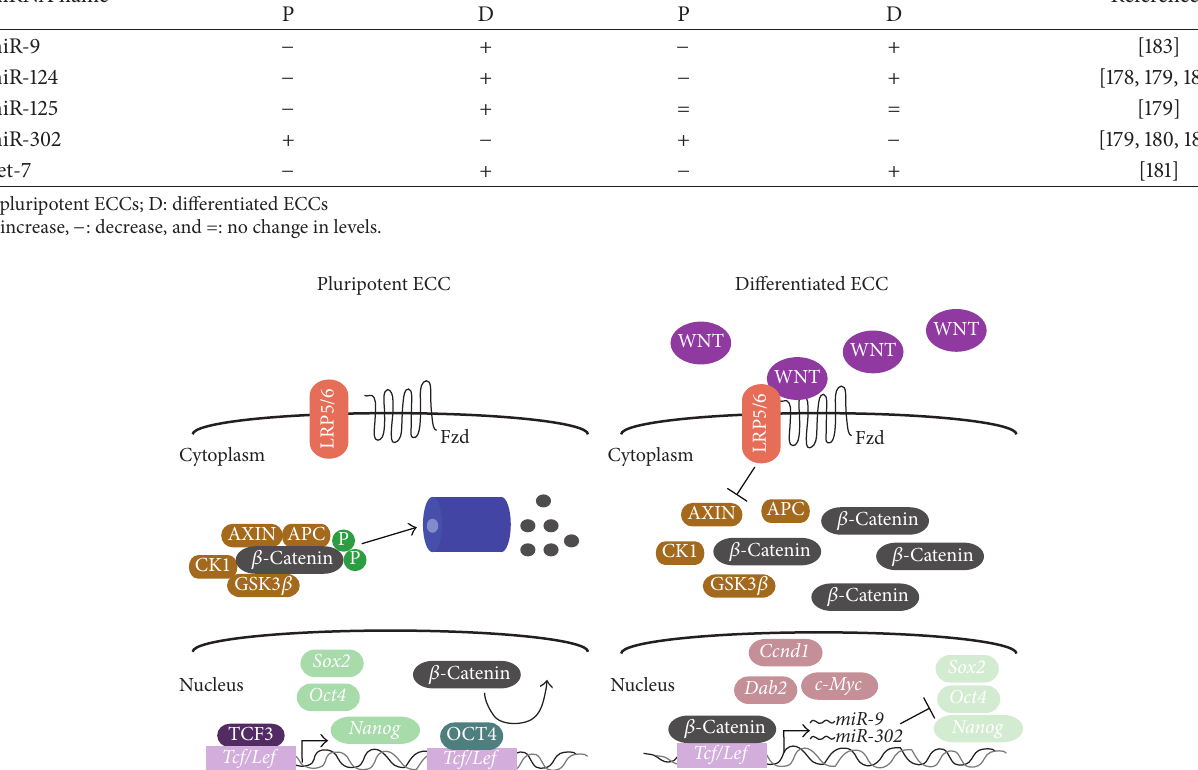
Figure 2: The dual role of WNT/ 𝛽 -catenin signaling ECCs stemness and differentiation. In the absence of WNT ligand, 𝛽 -catenin is phosphorylated and degraded by the proteasome; subsequently, TCF3, a transcriptional repressor of WNT target genes, translocates to the nucleus and upregulates pluripotency genes. TCF3-dependent upregulation of OCT4 allosterically binds to TCF/LEF, preventing 𝛽 - catenin from binding, which attenuates WNT signaling and differentiation. In the presence of WNT, AXIN is downregulated leading to the dissociation of the destruction complex, which results in the accumulation of 𝛽 -catenin in the cytoplasm and subsequent translocation to the nucleus where it binds to TCF/LEF proteins. As a result, WNT target genes including Dab2 , Ccnd1 , and c-Myc are upregulated leading to cell differentiation. 𝛽 -catenin-TCF/LEF interactions also result in the increase in miR-9 and miR-302 expression, which in turn downregulate the expression of pluripotency